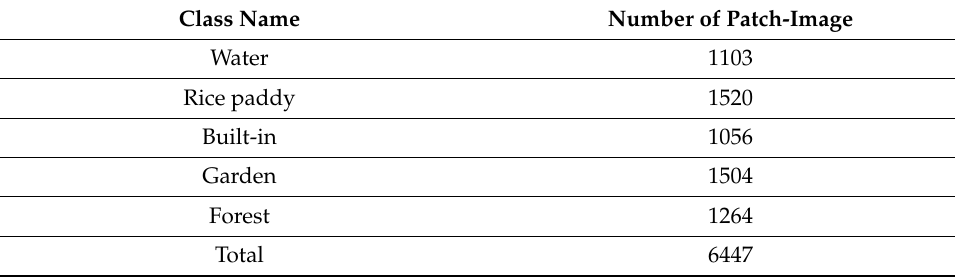
Table 3. Training set for CNN